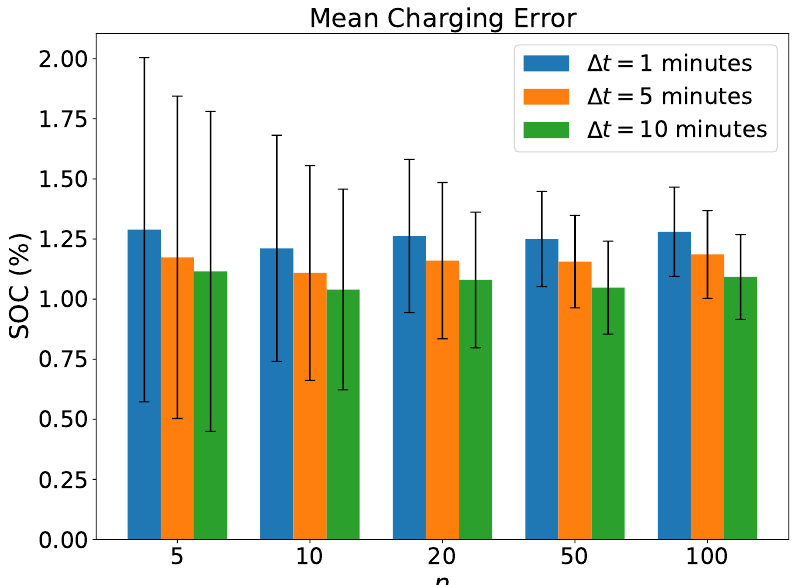
Figure 11. Mean charging error when scheduling with convex E max-lb v and realizing the plan with nonconvex E max-lb v using P gridmax = 40 n . Whiskers indicate the standard deviations.